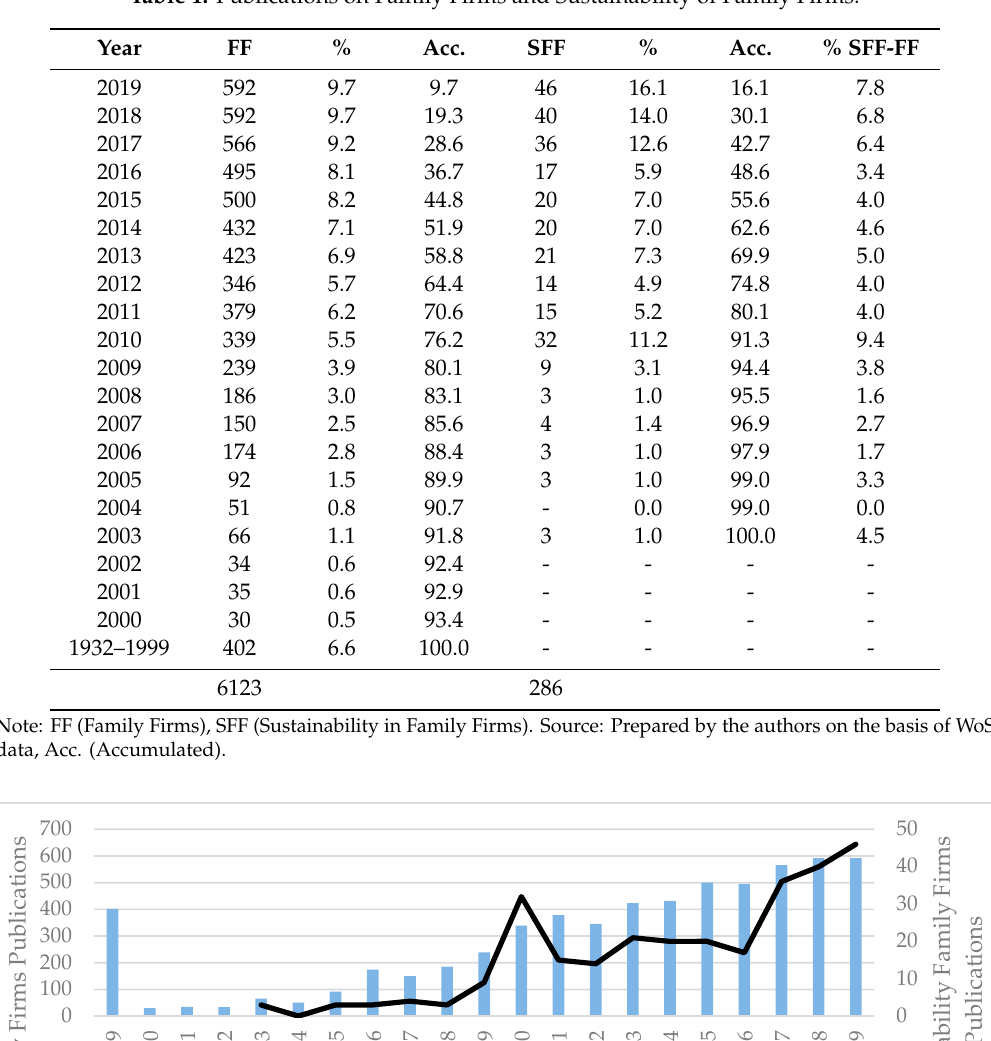
Table 1. Publications on Family Firms and Sustainability of Family Firms.